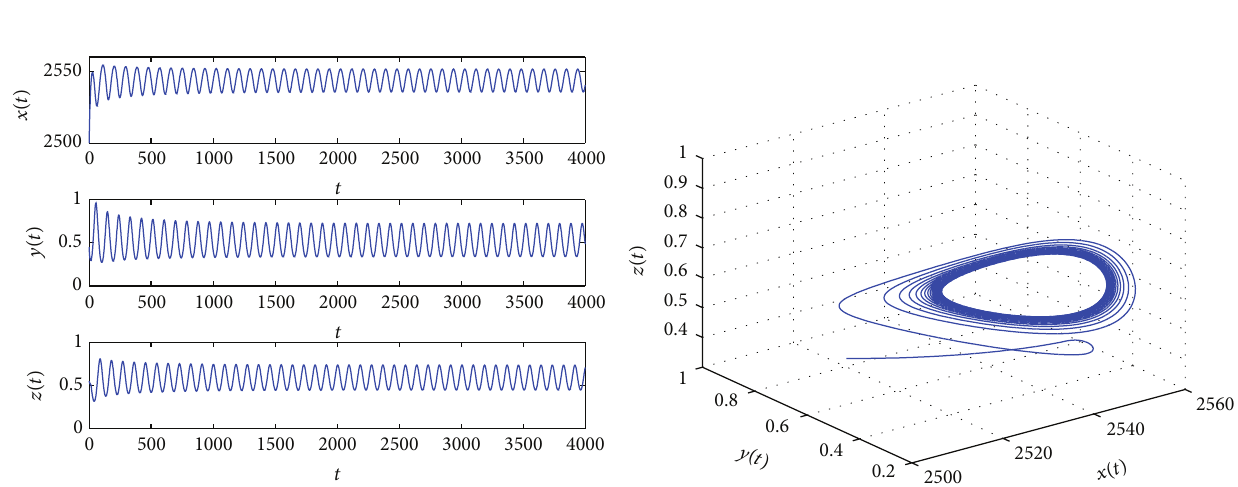
Figure 3: Stability of 𝐸 2 for 𝜏 = 5 .